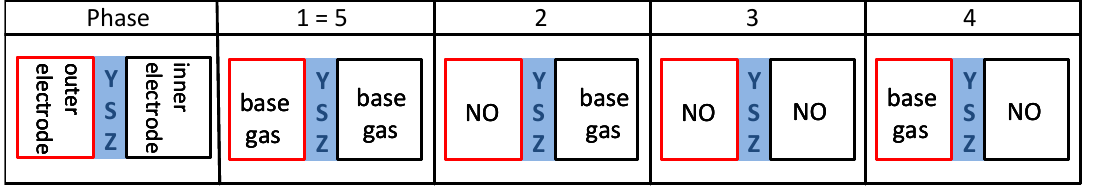
Figure 7. Different gas concentration on both electrodes during gas process including a NO step.